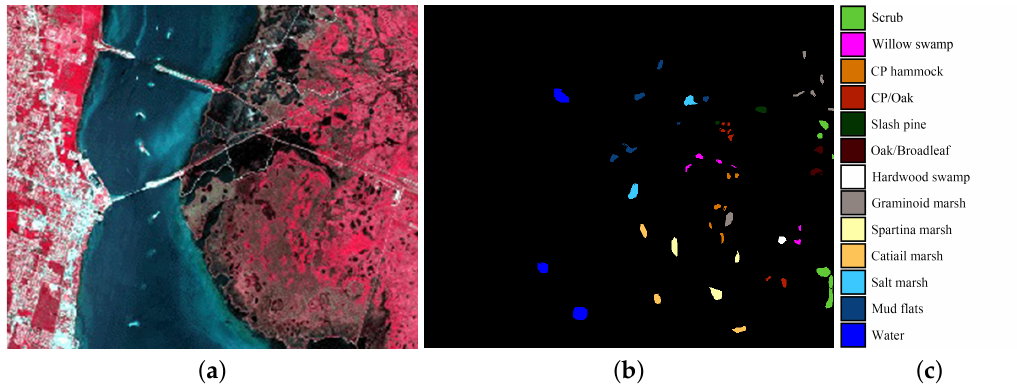
Figure 5. Kennedy Space Center data set. ( a ) false-color composite; ( b , c ) ground truth